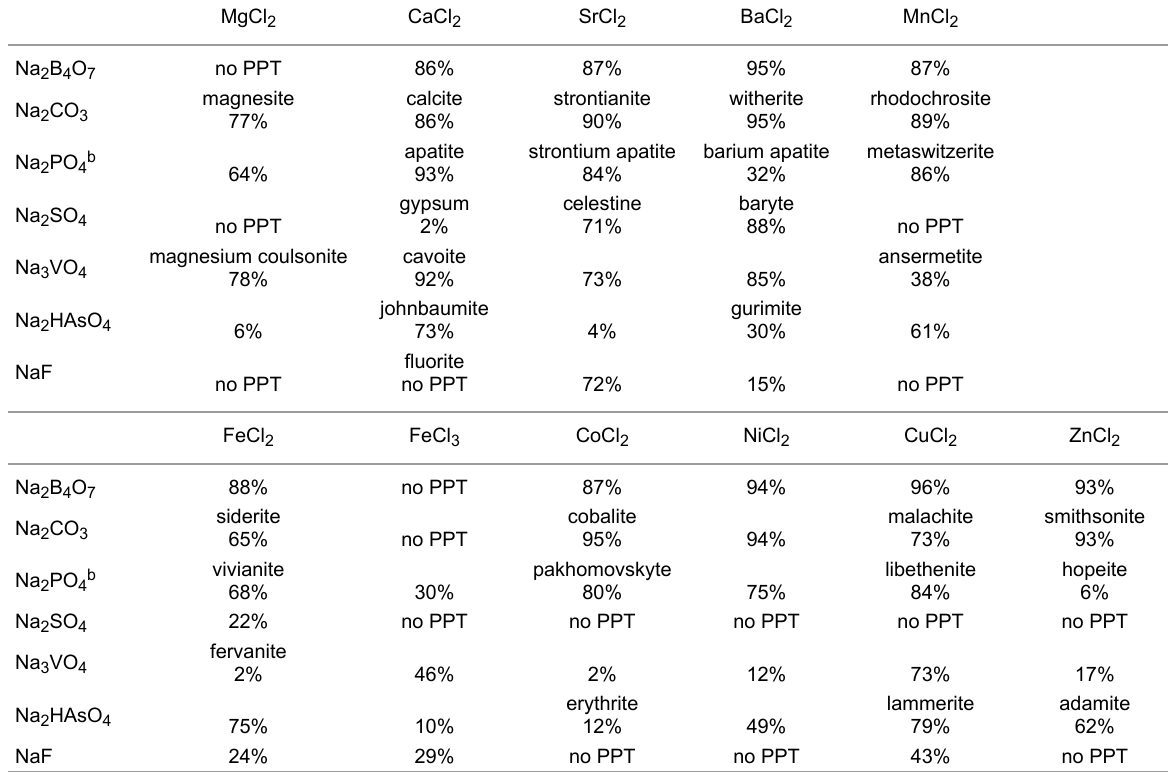
Table 1: Adsorption of RNA on synthetic minerals formed by double-decomposition reactions.